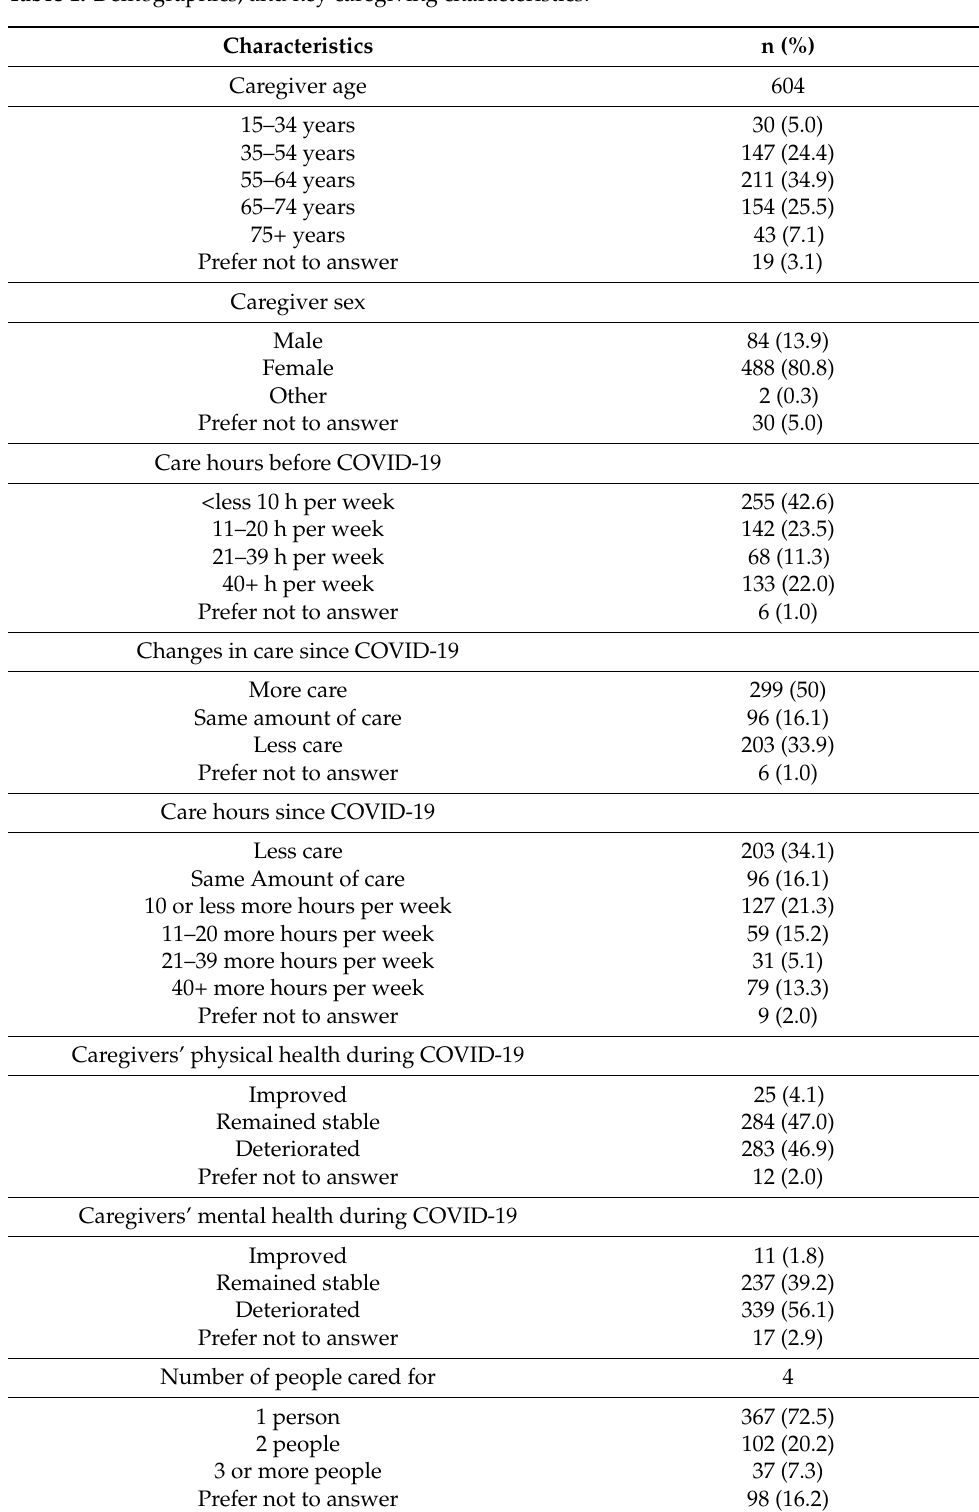
Table 1. Demographics, and key caregiving